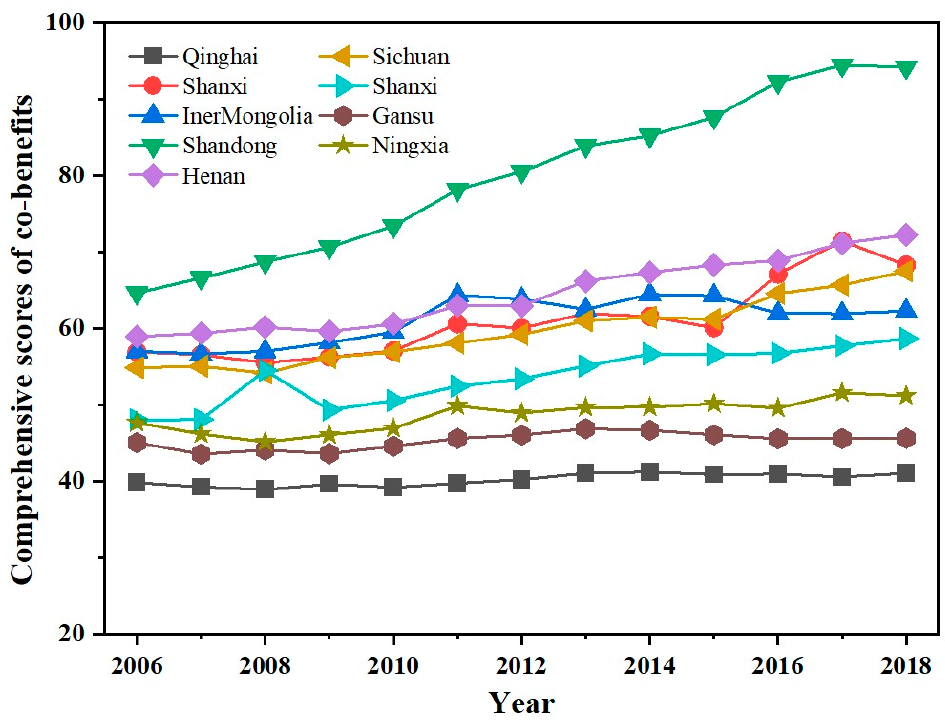
Figure 1. Line chart of the comprehensive scores of the co-benefits of carbon reduction and air pollution control in the YRB.